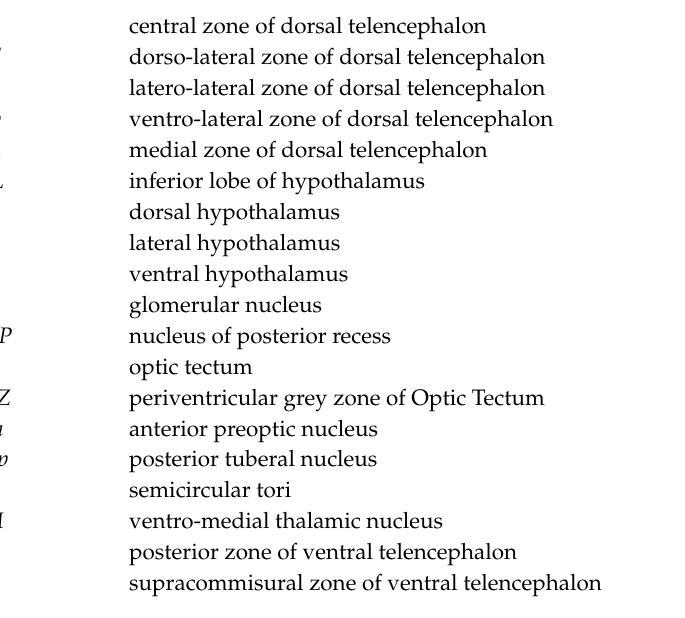
Figure S1: NESF-1 positive cells in the submucosa of the rostral intestinal bulb of young and old animals. Cell count was carried out manually on 7 consecutive sections by using an open source image-processing program (ImageJ). Cells were identified on the basis of their morphological aspect. The graphical analysis was produced by Excel and did not reveal any significance di ff erence between the two age points studied, Table S1: Ensemble Species Code, Table S2: Summary of primer pair sequences used for Real Time PCR (RT- PCR) and in situ hybridization